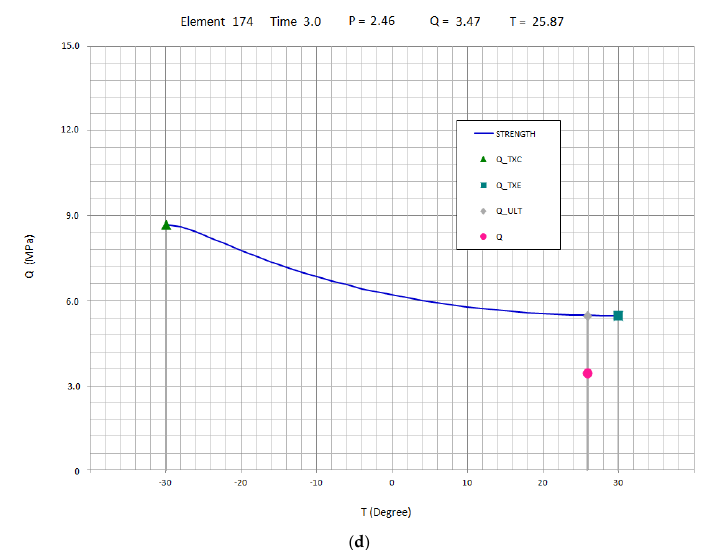
Figure 15 . Stress state at the first element along lines C5 and D6 (Ko = 0.5): ( a ) p – q plot at Location C; ( b ) t – q plot at Location C; ( c ) p – q plot at Location D; ( d ) t – q plot at Location D.